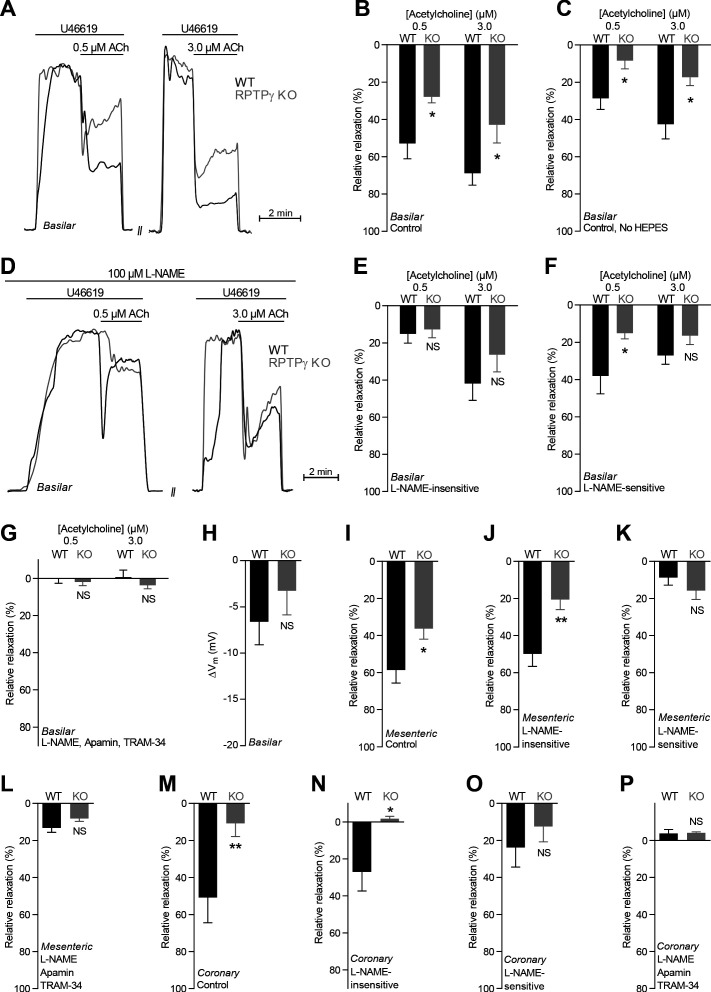
Acetylcholine (ACh)-induced endothelium-dependent vasorelaxation is compromised in basilar, mesenteric, and coronary arteries from RPTPγ KO mice when investigated in presence of CO2/HCO3–.(A and D) Force recordings illustrating acetylcholine-induced vasorelaxation of U46619-contracted basilar arteries under control conditions (A) and after treatment with 100 µM L-NAME (D). The pre-contraction force development in response to U46619 was normalized in order to display relative relaxations. (B, I, and M) Acetylcholine-induced relaxations of basilar (B, n = 7–9), mesenteric (I, n = 11–13), and coronary (M, n = 7) arteries from RPTPγ KO and WT mice under control conditions, i.e. without inhibitors of endothelial function. For mesenteric and coronary arteries, we applied a concentration of 0.5 and 3.0 µM acetylcholine, respectively. (C) Experiment similar to that in panel B but performed in a CO2/HCO3–-containing solution without HEPES (n = 9–10). (E, J, and N) Acetylcholine-induced relaxations of basilar (E, n = 7–9), mesenteric (J, n = 11–13), and coronary (N, n = 7) arteries from RPTPγ KO and WT mice after treatment with 100 µM L-NAME. For mesenteric and coronary arteries, we applied a concentration of 0.5 and 3.0 µM acetylcholine, respectively. (F, K, and O) Acetylcholine-induced L-NAME-sensitive relaxations of basilar (F, n = 7–9), mesenteric (K, n = 11–13), and coronary (O, n = 7) arteries from RPTPγ KO and WT mice calculated as the difference in relaxations with and without 100 µM L-NAME. For mesenteric and coronary arteries, we applied a concentration of 0.5 and 3.0 µM acetylcholine, respectively. (G, L, and P) Acetylcholine-induced relaxations of basilar (G, n = 7–9), mesenteric (L, n = 11–13), and coronary (P, n = 7) arteries from RPTPγ KO and WT mice after treatment with 100 µM L-NAME, 50 nM apamin, and 1.0 µM TRAM-34. For mesenteric and coronary arteries, we applied a concentration of 0.5 and 3.0 µM acetylcholine, respectively. (H) Vascular smooth muscle cell membrane potential responses (ΔVm) to 3.0 µM acetylcholine in basilar arteries from RPTPγ KO and WT mice in presence of 100 µM L-NAME. Data were compared using two-way ANOVA followed by Sidak’s post-test (panel B, C, and E-G), non-parametric Mann-Whitney test (panel H, K-M, and O), unpaired two-tailed Student’s t-test (panel I and J) or unpaired two-tailed t-test with Welch’s correction (panel N and P). Comparisons in panel B and J were made after square root transformation. *p<0.05, **p<0.01, NS: not significantly different vs WT.